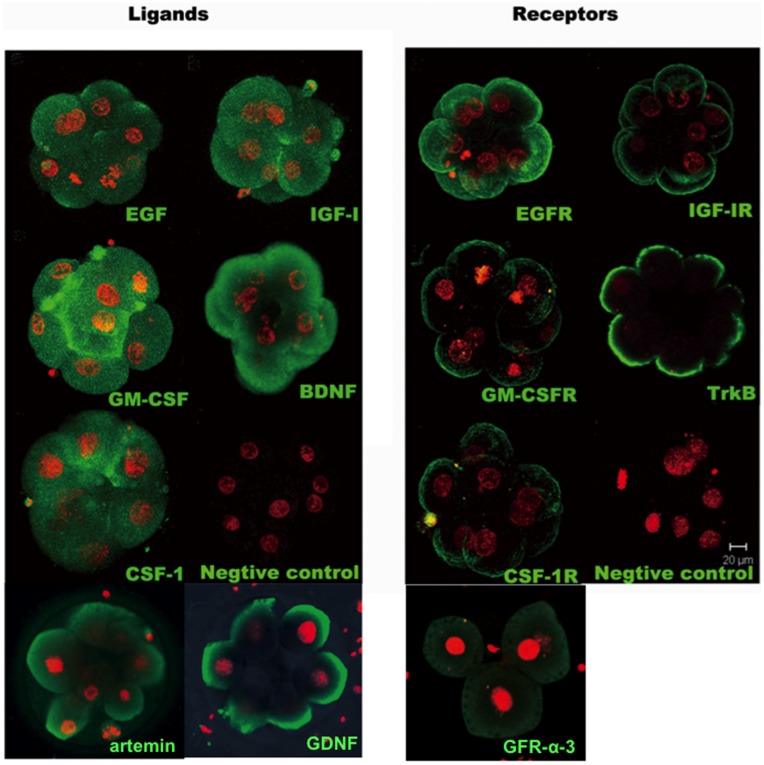
Immunofluorescence staining of polypeptide ligand-receptor pairs of key growth factors in triploid human embryos.Tri-pronuclear zygotes discarded from the IVF program were cultured to generate cleavage stage embryos (3–10 cell-stage) for immunostaining using specific antibodies against different ligands and receptors. Green signals for ligand/receptor pairs (EGF/EGF receptor, IGF-1/IGF-1 receptor, GM-CSF/GM-CSF receptor, BDNF/TrkB, CSF-1/CSF-1 receptor, atermin, GDNF/Anti-GFR alpha 3) were found following staining with specific antibodies. Embryonic nuclei were stained with propidium iodide (red signals). Negative controls were incubated with nonimmune IgG. Bar = 20 µm.